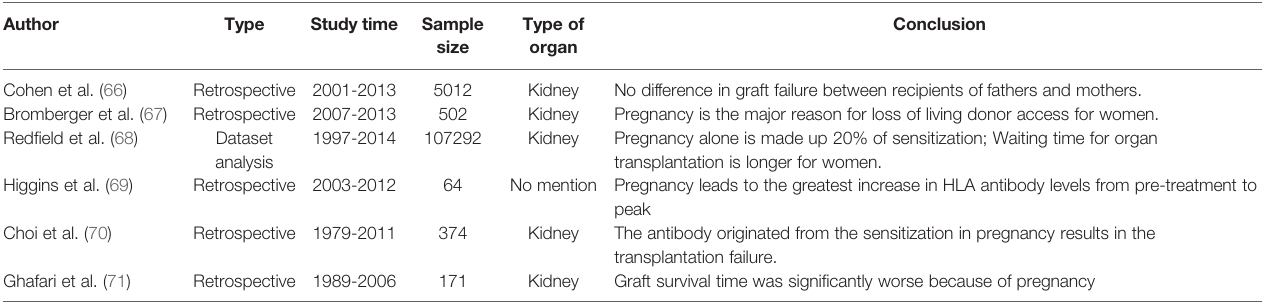
TABLE 2 | Adverse effect of pregnancy on subsequent organ